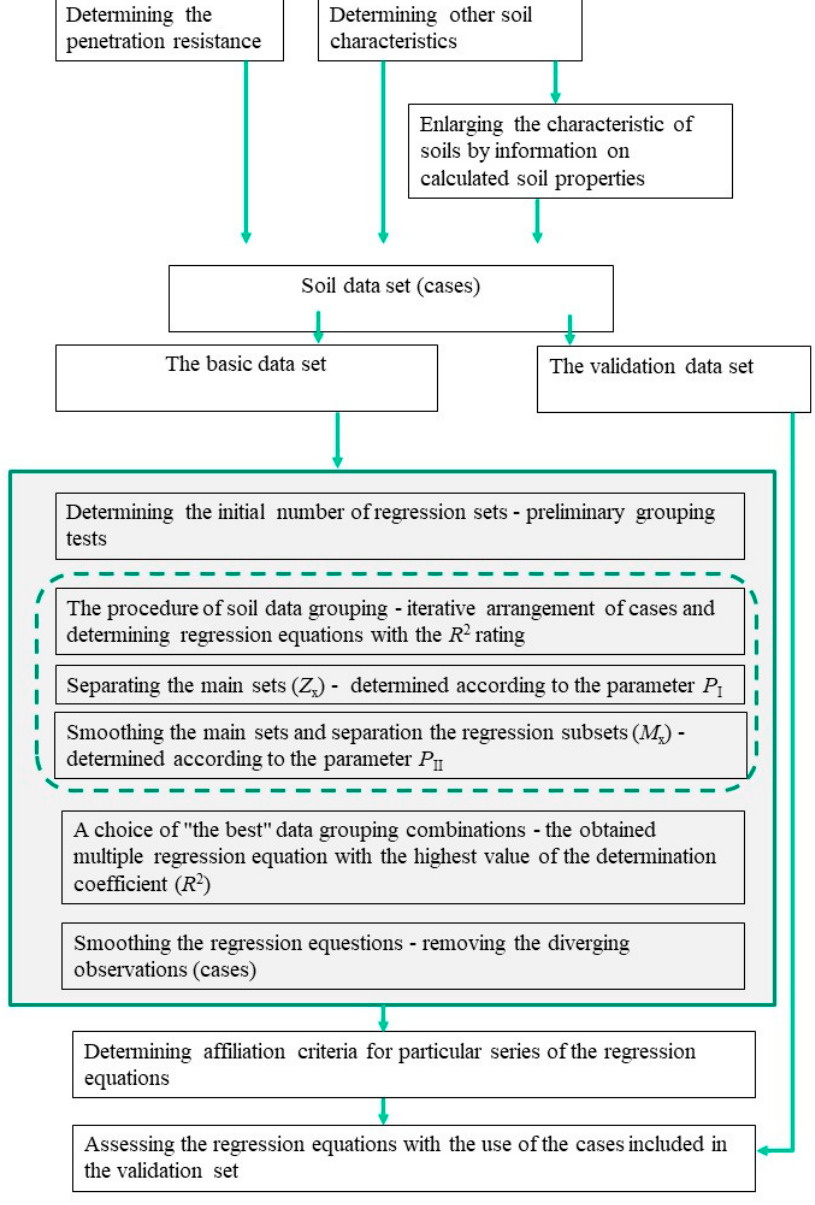
Figure 1. A schematic of the methodology of the presented study.